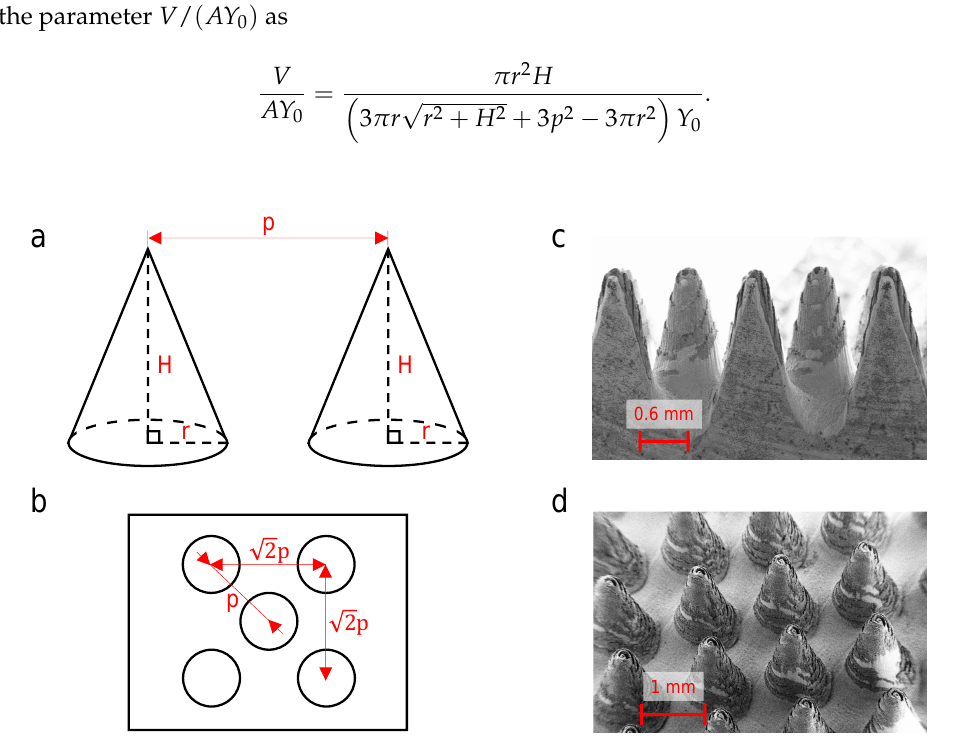
Figure 3. Cones patterns: ( a ) Schematics of the lateral and ( b ) top view of the cones pattern. ( c ) Image of laser-etched cones pattern as obtained by FESEM at 100 × and ( d ) 74 × magnification: The FESEM pictures are provided by Microla Optoelectronics S.r.l., using 30 µ m aperture size, 7 mm (panel c) and 10 mm (panel d) working distance, and 5 kV electron high tension.